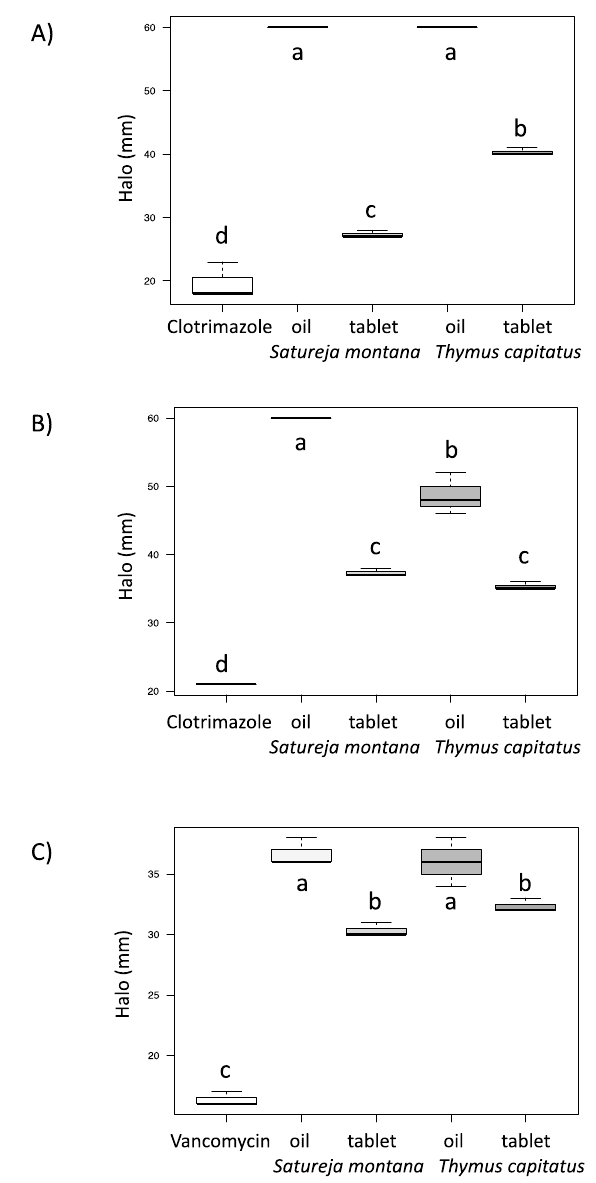
Figure 7. Disk diffusion assay. The halo diameters (mm) were recorded using calipers. Two EOs extracted from S. montana and T. capitatus were tested as both pure oils or as tablets. Clotrimazole and vancomycin were used as positive controls. ( A ) C. albicans ATCC 14053, ( B ) C. glabrata ATCC 15126 and ( C ) S. aureus NCTC 6571. Different letters above the boxes indicate significant differences according to one-way ANOVA followed by Tukey ’s HSD test ( p < 0.05).